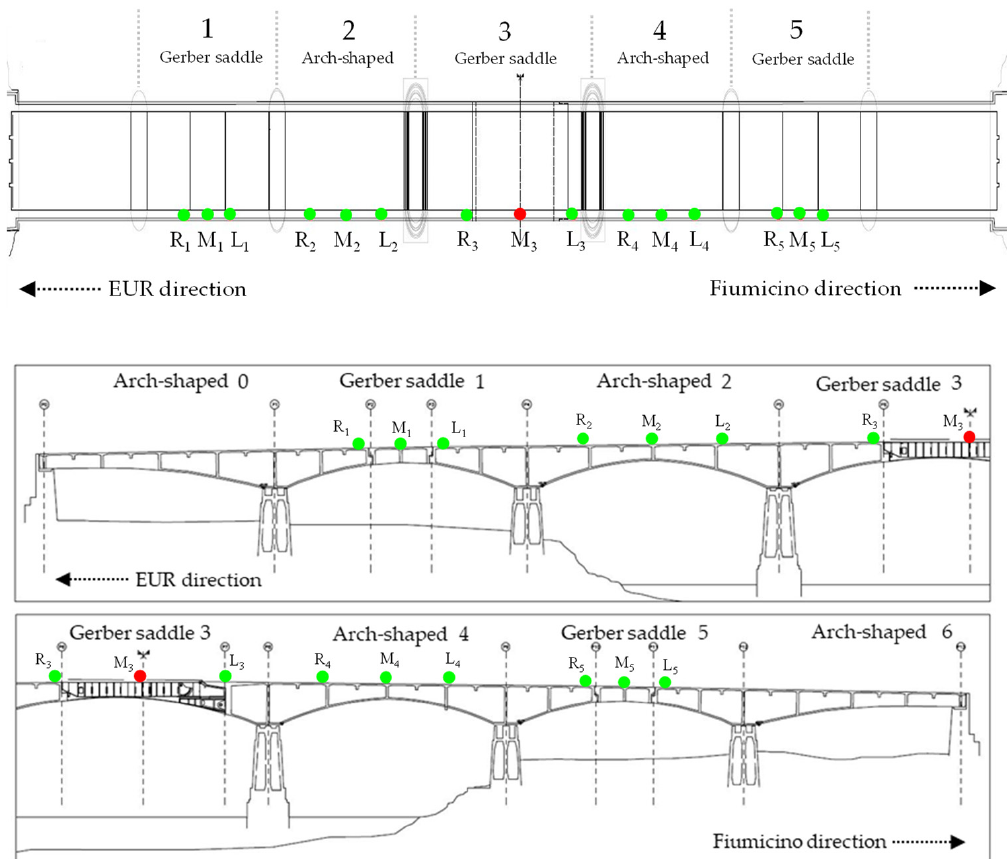
Figure 7. Planimetric ( above ) and lateral ( below ) deployment of the five experimental layouts. The circles represent the location of the operating (green) and not operating (red) sensors. R: right; M: midpoint; L: left.